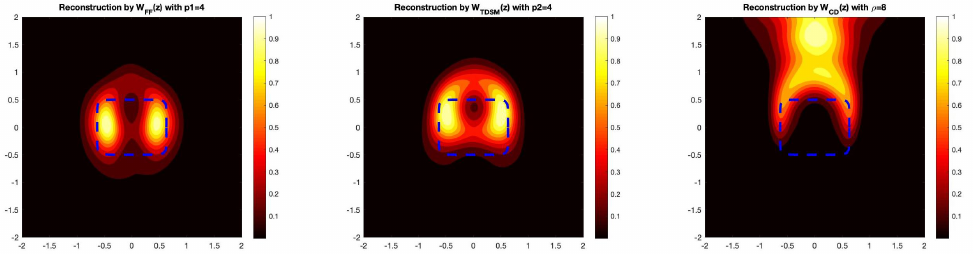
Figure 7. The reconstruction of the rounded square with 1/2 partial aperture data, i.e., measurements only taken on θ j ∈ [ 0, π ) . In this example, we take δ = 0.05, which corresponds to a 5% noise